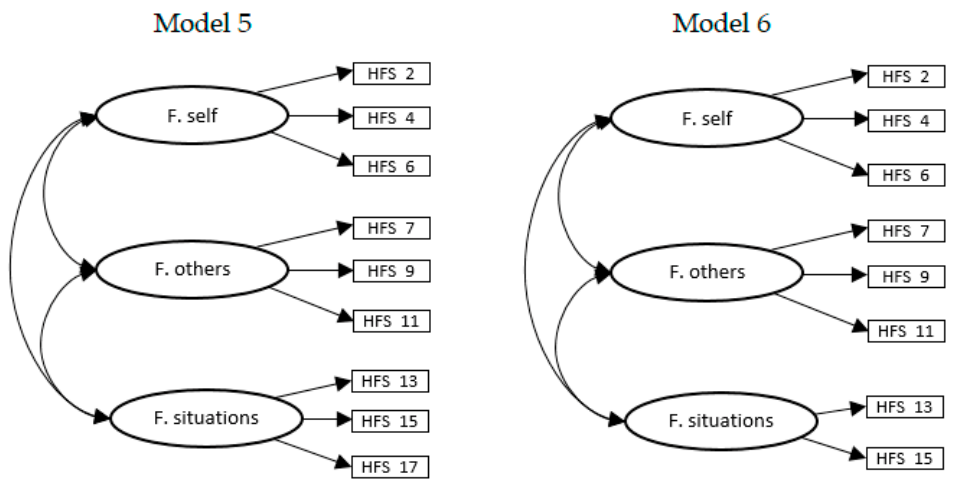
Figure 3. Model 5 and model 6. F. self = forgiveness of self; F. others = forgiveness of others; F. situations = forgiveness of situations.